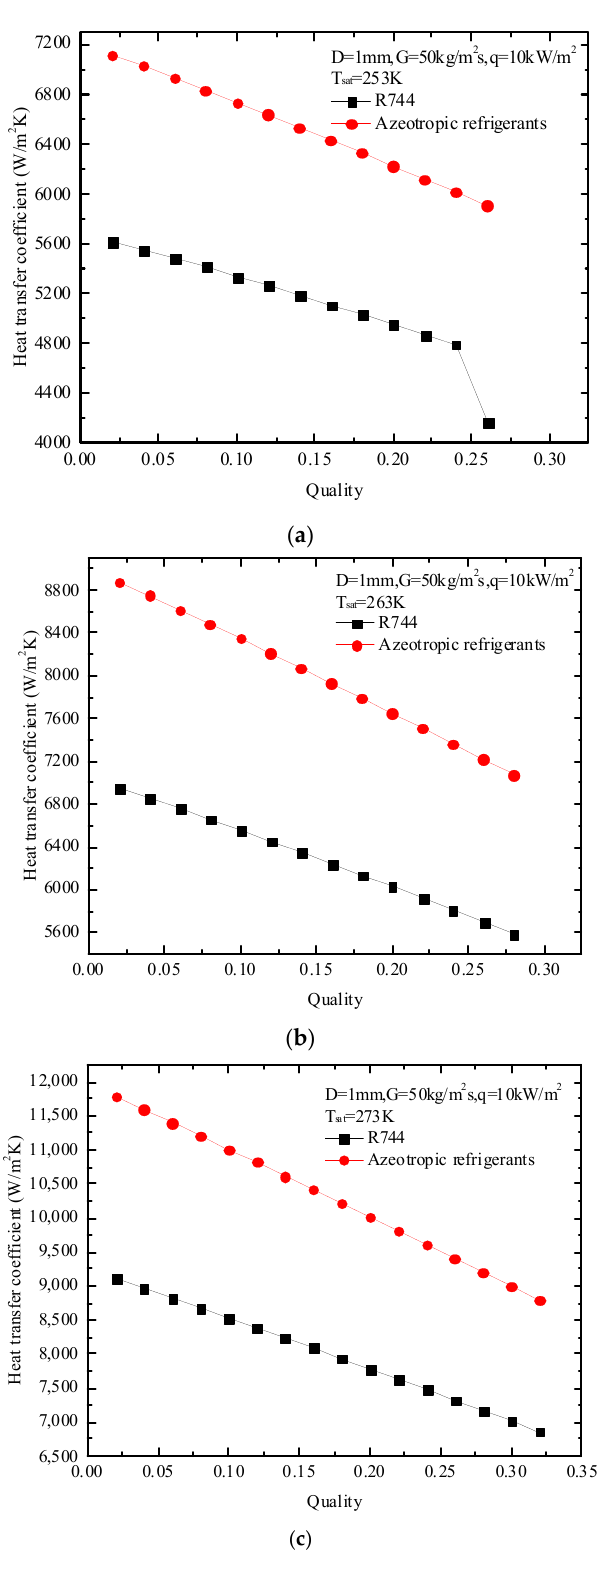
Figure 18. Comparison of heat transfer coefficients between azeotropic refrigerant and R744 at different T sat values: ( a ) T sat = 253 K; ( b ) T sat = 263 K; ( c ) T sat = 273K.